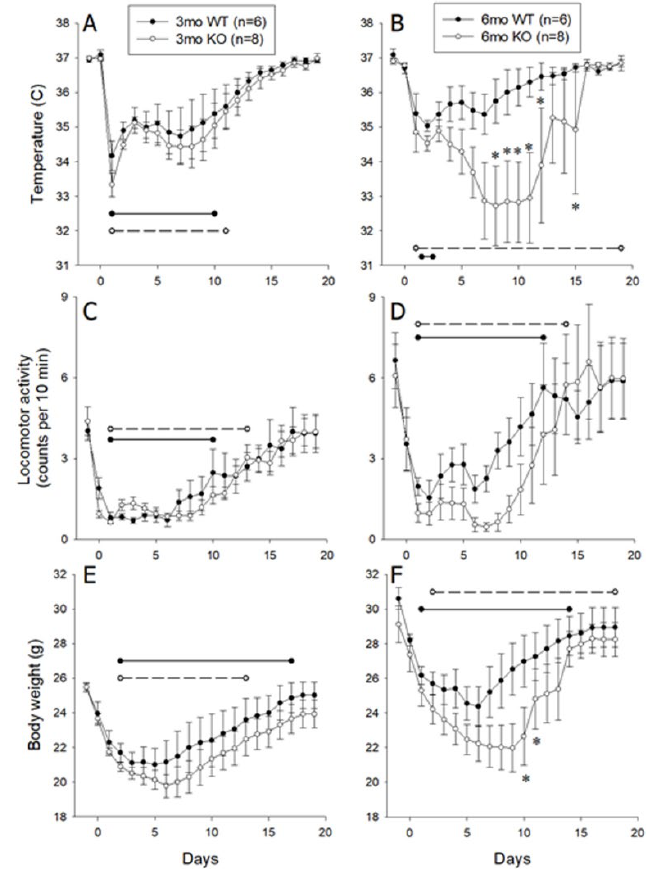
Figure 2. Locomotor activity, temperature and body weight in ALOX8 +/+ and ALOX8 − / − mice before and after influenza inoculation. Activity and temperature data were collected using an intraabdominal transmitter. These data are presented as average daily values and SEM based on continuous 10-minute periods of data acquisition for locomotor activity and one reading every 10 minutes for temperature. Body weight was measured daily. Left panels show data from 3-month-old mice ( n = 6 ALOX8 +/+ mice and n = 8 ALOX8 − / − mice); right panels show data from 6-month-old mice ( n = 6 ALOX8 +/+ mice and n = 8 ALOX8 − / − mice). Horizontal lines denote significant di ff erences from baseline values ( ALOX8 +/+ , solid; ALOX8 − / − , dashed). Asterisks denote significant di ff erence between ALOX8 +/+ and ALOX8 − / − mice at the designated time